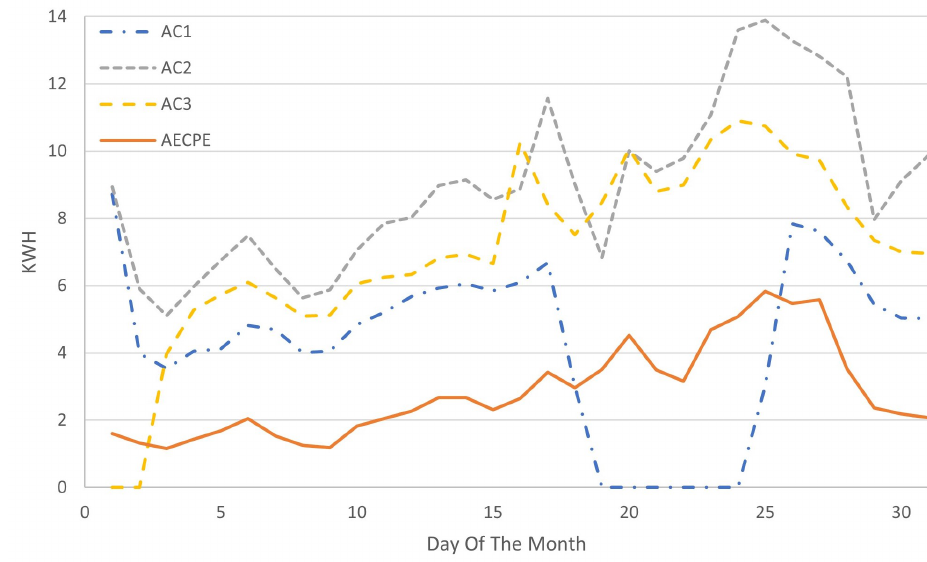
Figure 7. October results from the field